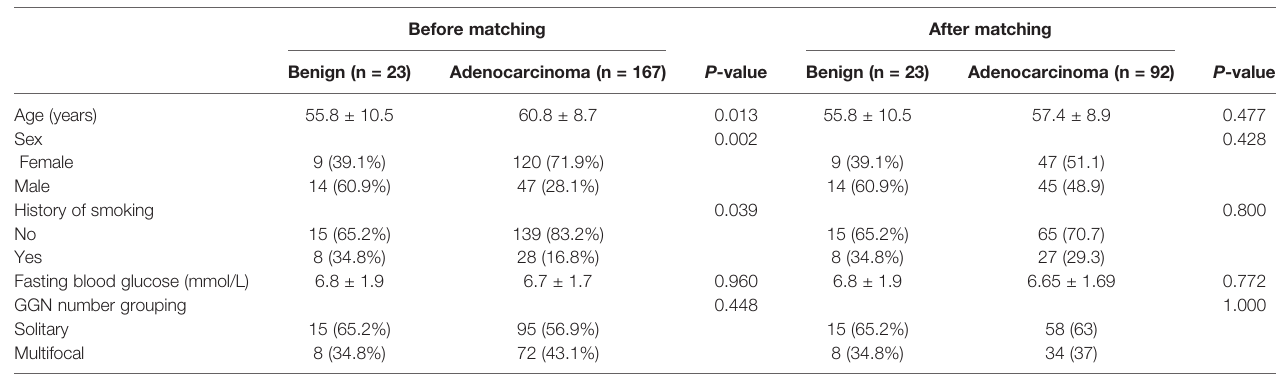
TABLE 1 | General data of GGNs in benign group and adenocarcinoma group before and after PSM. Before matching After